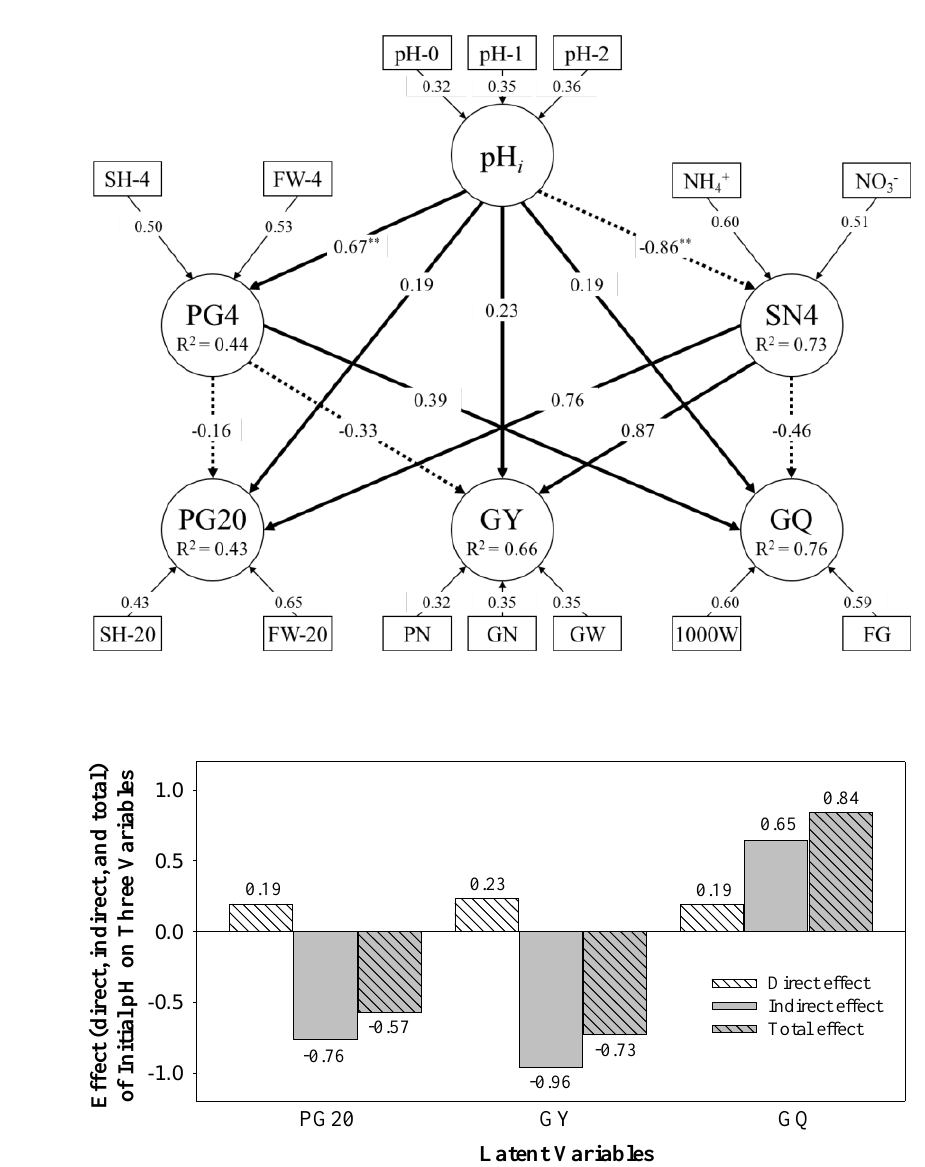
Figure 2. Result of partial least squares path modeling (PLS-PM). (a) Unidirectional cause–effect between six latent variables are shown as an arrow with path coefficients on it (solid and dotted arrows denote positive and negative effects, respectively). The value above the arrow in the outer model represents the weight of the measured variable. The number of asterisks indicates the significance level ( ** p < 0.01). R 2 indicates the determination coefficient of each latent variable in the inner model. (b) Direct, indirect, and total effects of initial paddy soil pH (pH i ) on three latent variables related to rice growth and productivity (PG20, GY, and GQ).